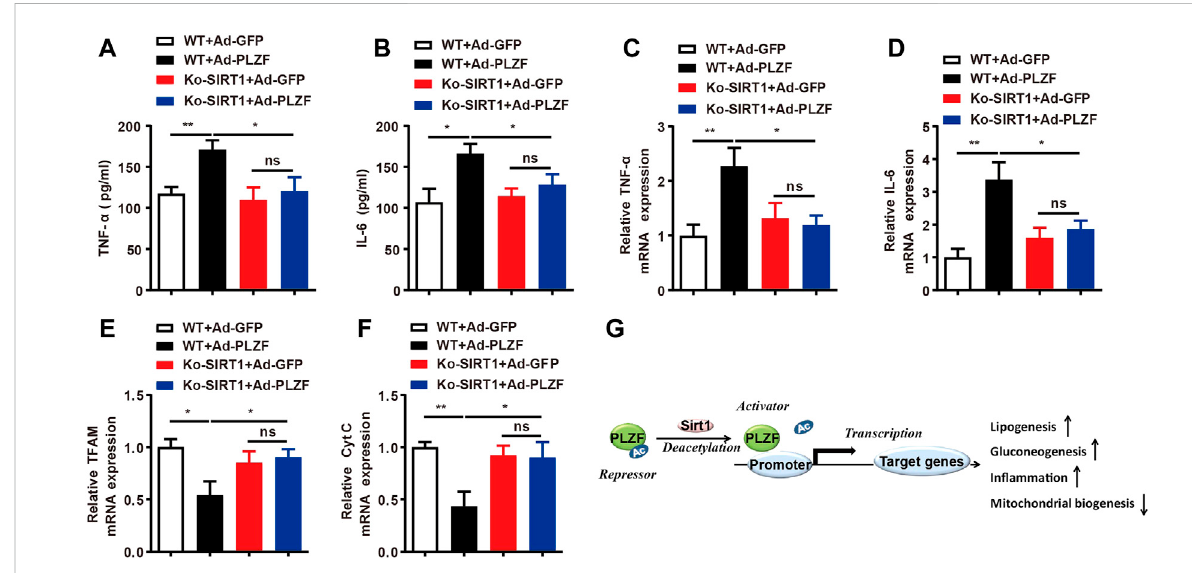
FIGURE 7 Hepatic PLZF overexpression induces theexpression of in fl ammatory factors and inhibits mitochondrial biogenesis through SIRT1. (A,B) Serum TNF α and IL-6 levels were determined with ELISA assay in the mice with indicated treatment. (C,D) Liver TNF α and IL-6 mRNA expression was determined with qPCR assay in the mice with indicated treatment. (E,F) Liver TFAM and Cyt C mRNA expression was determined with qPCR assay in the mice with indicated treatment. (G) Schematic representation of PLZF mediated hepatic lipid homeostasis. N = 6 – 8/group. For adenovirus injection, mice were injected via their tail vein with adenovirus. Then, 5 – 7 days after infection, mice livers and plasma were collected for further analysis. The data shown are the means ± SEM. * p < 0.05, ** p <